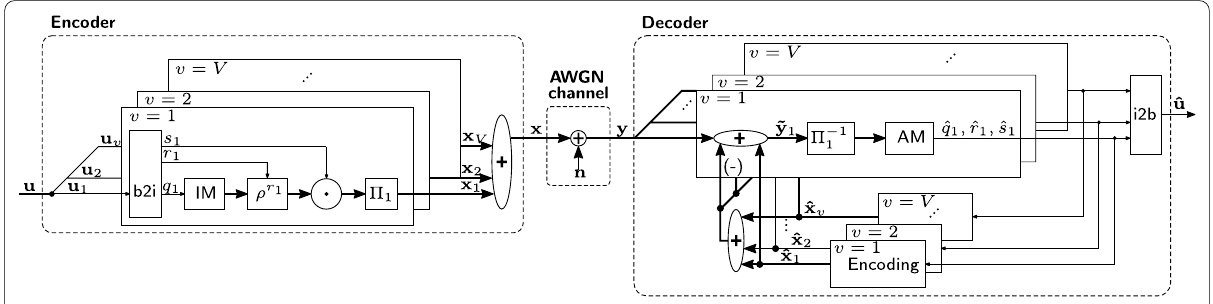
Fig. 2 Integer-HDM encoder and decoder: binary string u ∈ { 0,1 } k is encoded to HD superposition x ∈ Z D which is transmitted over an AWGN channel. The received vector y is finally decoded using an iterative unit-feedback decoder with unit feedback yielding the estimation ˆ